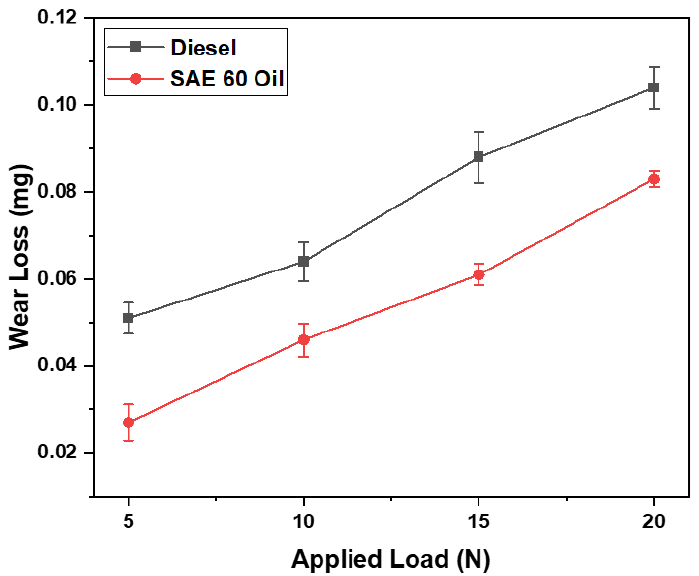
Figure 13. Effect of applied load on coefficient of friction in wet condition for Al-CNT-Sn specimens with 1.0 wt. % CNT.